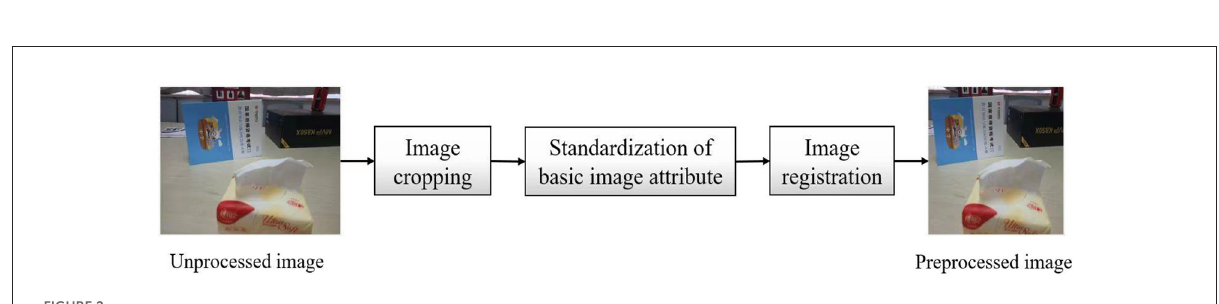
FIGURE2 Schematic diagram of Image